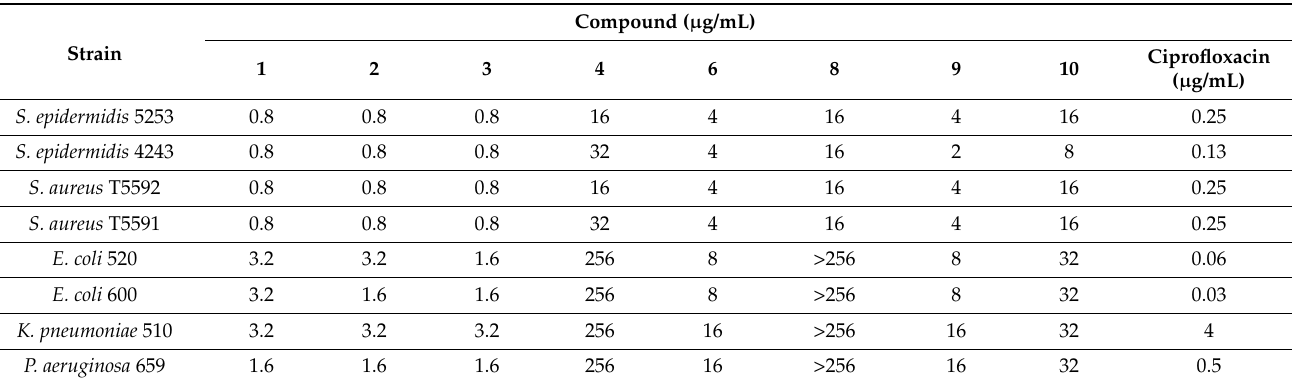
Table 4. Activity of the selected derivatives against clinical isolates, expressed by minimal inhibitory concentrations ( µ